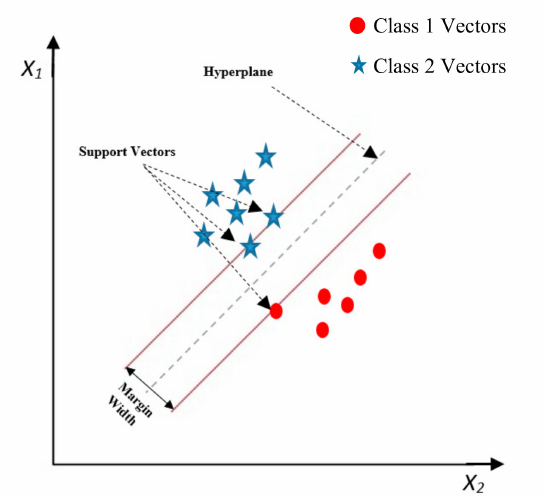
Figure 2. Data separation by